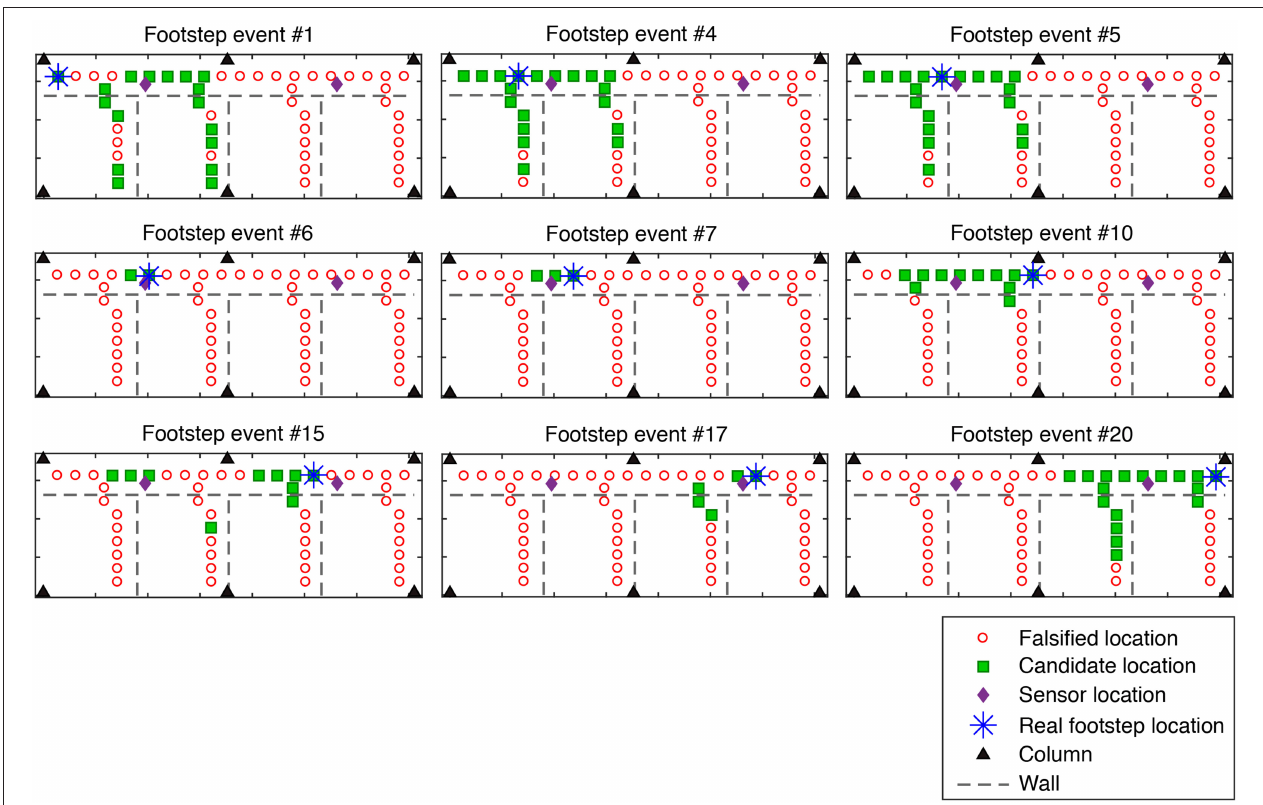
FIGURE 9 | Candidate-location set that is obtained using EDMF and sequential analysis (see Figure 3 ) for each footstep event of trajectory